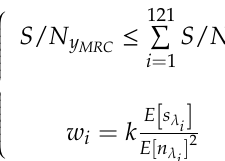
( c ) Figure 10. The three different postures for examining PPG measurement at different hydrostatic pressures: ( a ) Posture 1—hands down (−90 ° ); ( b ) Posture 2—hands forward (0 ° ); ( c ) Posture 3—hands up (+90 ° ).